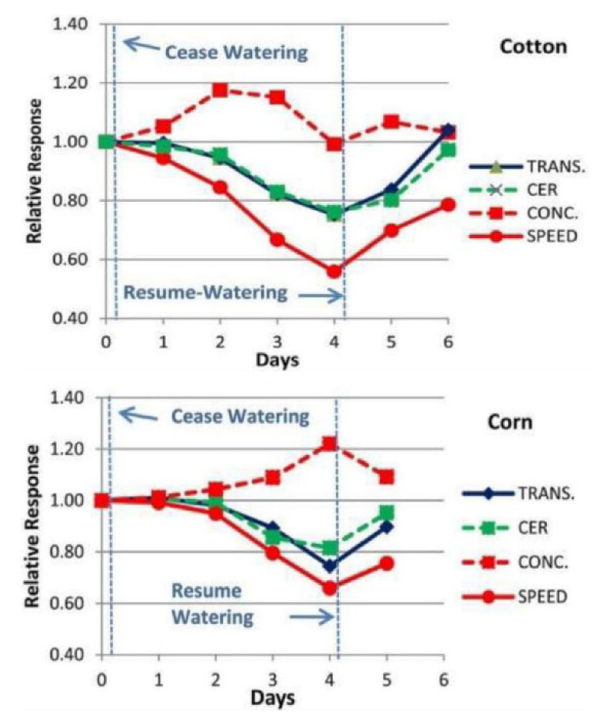
FIGURE 2 | Example of the changes in Phloem Transport Speed and Concentration (measured experimentally by Carbor-11 Traces kinetic analysis, Goeschl et al., 1988; Goeschl, 2019) along with changes in CER and Transpiration of a Cotton and Corn plant during a 4 days “drydown” and re-watering experiment of the type conducted by Boyer